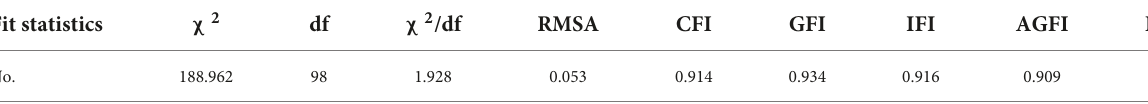
TABLE 2 Confirmatory factor analysis of CPS-CS, indexes of the